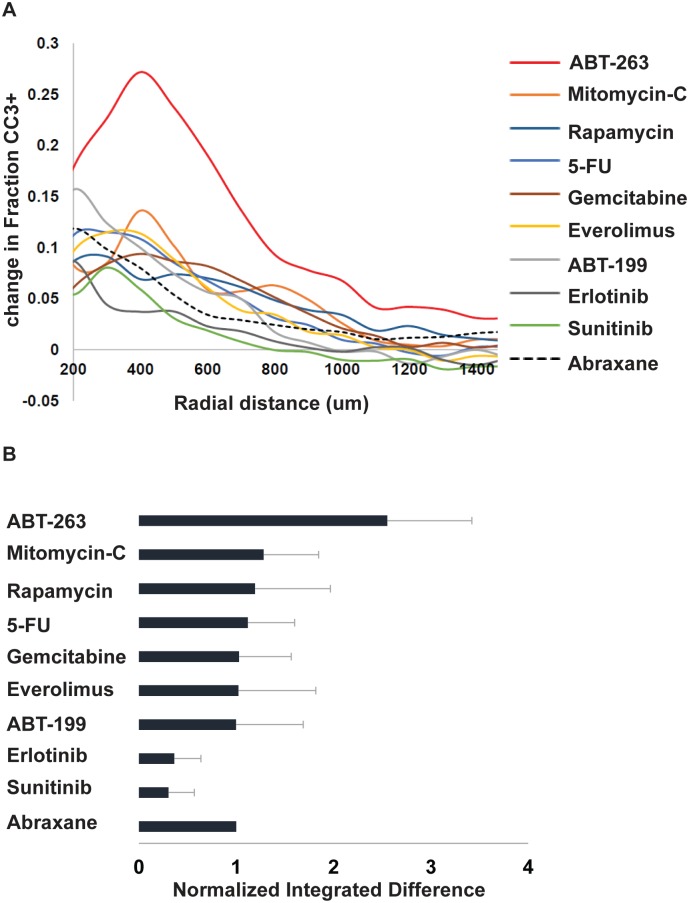
CIVO analysis identifies ABT-263 as the agent that leads to the greatest increase in cytotoxic response when combined with Abraxane.(A) Plots show the difference in fraction CC3+ cells averaged across n = 4 MiaPaCa2 tumors for each agent combined with Abraxane® (ABX) versus the corresponding single agent, as a function of radial distance from the injection site. Among the curves, ABT-263 shows a greater than two-fold higher increase compared to other agents. The increases for other agents were similar to the single-agent effect of ABX alone (dashed curve) suggesting simple additivity of responses for these agents. (B) For statistical comparisons, the areas under each curve were integrated and normalized, dividing by the average area under the ABX curve. The bar chart shows estimates of these integrated differences with standard errors derived from a linear mixed effects model. Of the combinations tested, only ABT-263 plus ABX elicited a statistically significant greater apoptotic response than ABX alone (p<0.01 Wald’s test).